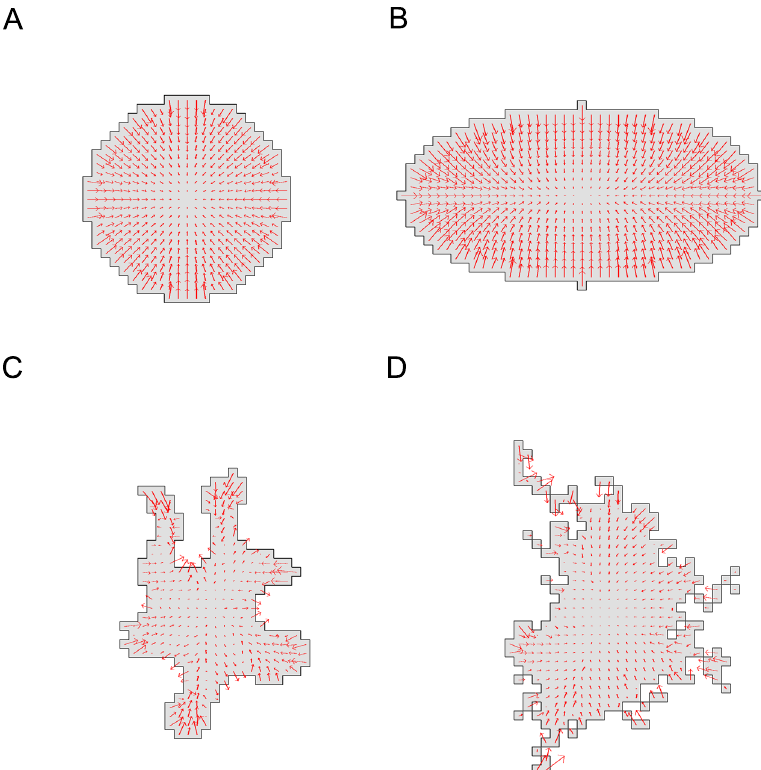
Fig 2. Forces predicted for several cell shapes. Force fields predicted by our complete method (smoothing and interpolation) for four simulated cell shapes in the CPM. (A) Circular cell (area A = 401, perimeter P = 74, diameter = 23). (B) Elliptical cell (area A = 629, perimeter P = 101, axes lengths 21 and 41). (C) Irregular cell shape (area A = 301, perimeter P = 118). (D) Highly irregular cell shape (area A = 400, perimeter P = 146). Parameter values were a = 300, λ a = 10, p = 100, λ p = 10, J (0, 1) = 3000, ξ ( r ) = 18, and r = 3 for all neighborhood calculations. We used a grid of 50 by 50 lattice sites with Δ x = 1. See also Supplementary Figures S6–S8 Figs for intermediate steps in the calculation of